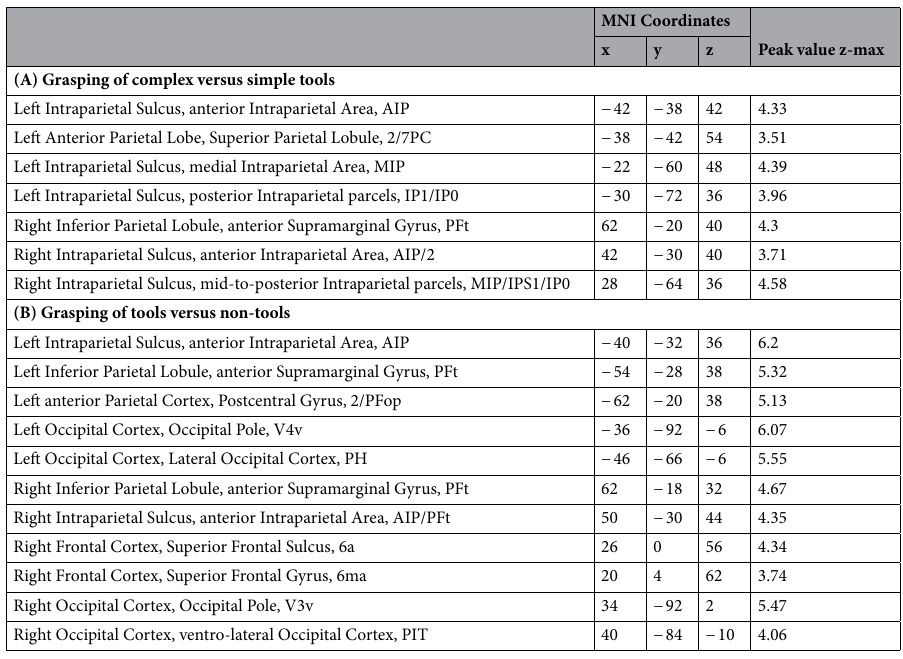
Table 1. Peak Montreal Neurological Institute (MNI) coordinates and peak values of the regions exhibiting significant activity in two major contrasts from the main experiment. For each area/cluster identified with a given contrast, MNI coordinates of local peaks and maximal Z values are reported. These clusters were obtained using the modeling of random-effects components of mixed-effects variance and thresholded at Z > 3.1, p = 0.001, with family-wise error rate (FWER) corrected at α ≤